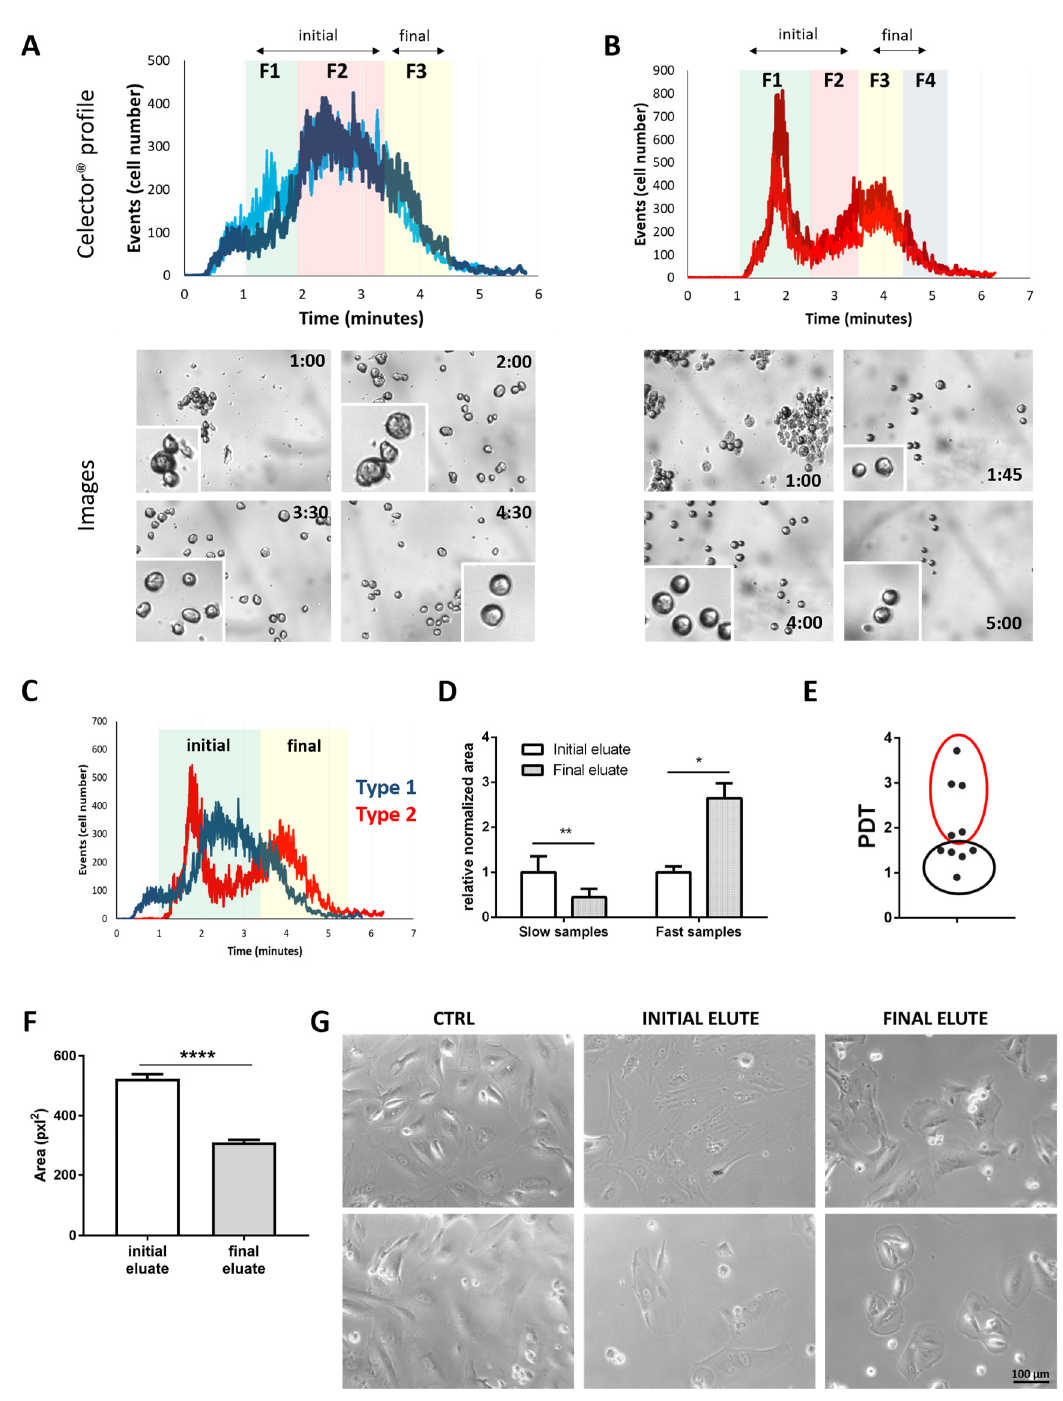
Figure 1. Celector ® sorting profiles of hAFSC samples. hAFSCs populations showed two types of profiles. Type ( A ) samples were divided into 3 fractions (F1, F2 and F3) while type ( B ) in 4 fractions (F1, F2, F3 and F4). Representative images and magnifications of eluting cells during time of analysis are shown below each profile. ( C ) The overlay of the two graphs are shown. In this graph is shown the division in initial and final eluate that was made to simplify all readouts. ( D ) The column graph shows the relative normalized area under each part of the Celector ® profile curve (Initial eluate = F1/F2; Final eluate = F3/F4). ( E ) The proliferative profile of hAFSCs populations is calculated by doubling population time (PDT) at passage three of the two groups of samples. ( F ) The area of eluting cells for each fraction in pixel 2 . It is shown how final eluted cells are smaller, while initial cells have a similar-fibroblastic morphology with larger and more elongated cyto- plasm. ( G ) hAFSCs representative images of initial and final eluted cells after few days of culture post Celector ® selection. Statistical analysis: * p value < 0.05; ** p value < 0.01; **** p value < 0.0001.